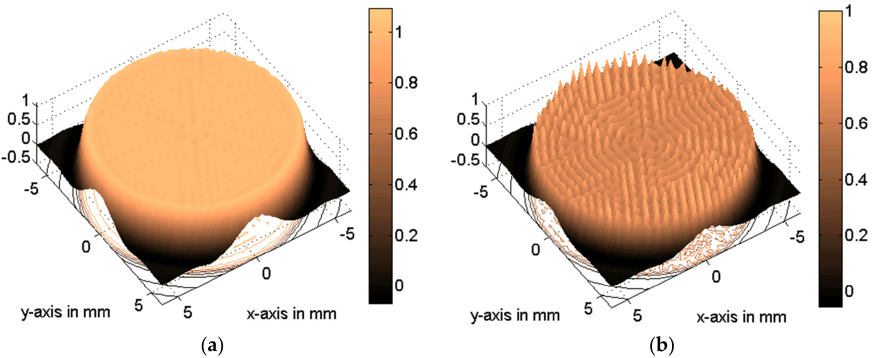
Figure 5. The normal velocity on the transducer face computed by the DPSM technique when the transducer face is modeled by ( a ) source clusters, as shown in Figure 3 (new formulation); and ( b ) individual point sources as shown in Figure 1 (old formulation).